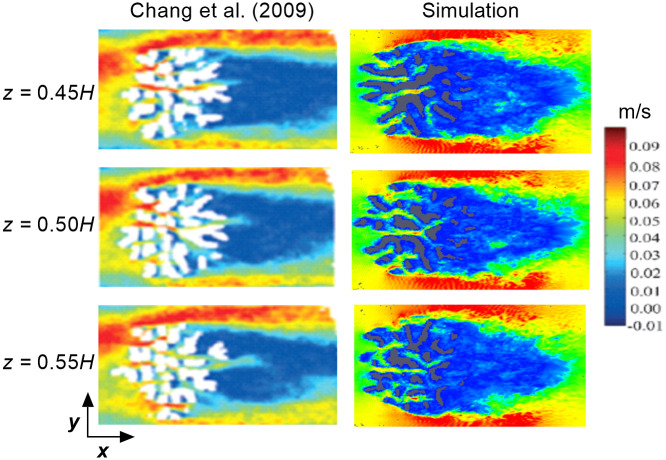
Comparison of top view velocity slices between an experiment and the present simulation at different heights inside the corals.(Left) Top view of velocity slices inside an S. pistillata colony obtained by magnetic resonance velocimetry [31] at the colony mid-height (z = 0.5H, middle slice) and two neighboring slices obtained at 5-mm distances above and below the mid-height level. Reproduced with permission from Limnology and Oceanography 54, 1819 (2009). Copyright 2009 by John Wiley and Sons, Inc. (Right) Present LES simulations of the velocity magnitude obtained inside the P. meandrina colony at the same normalized height as the experiment.